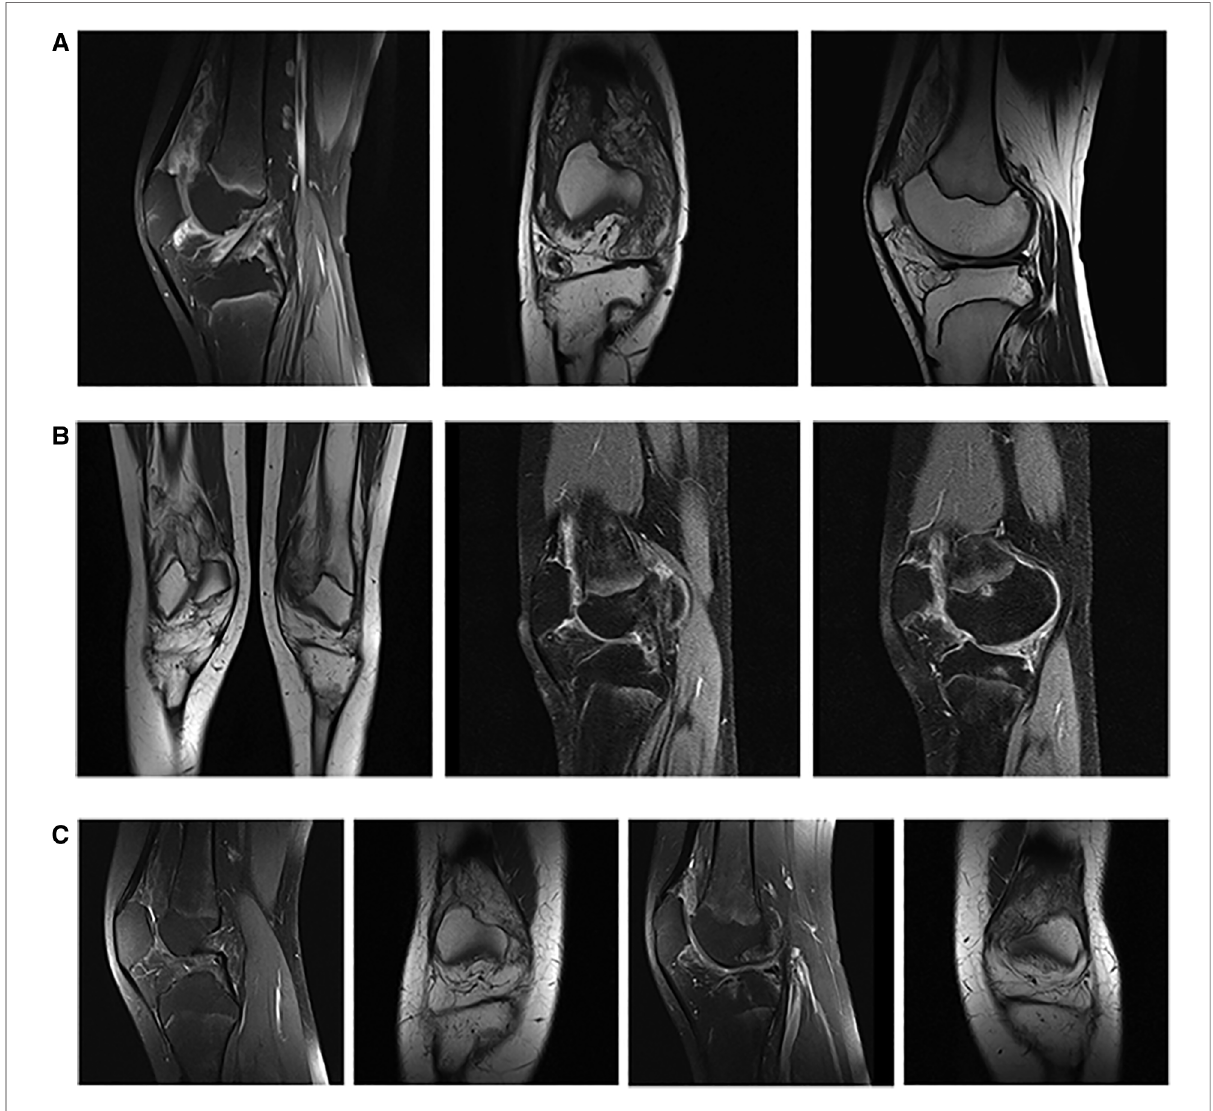
FIGURE 2 Imaging examinations. ( A ) Initial MRI scanning of the right knee [MRI Proton Density with Fat Saturation (PDFS), sagittal plane; MRI T1 weighted image, coronal plane; MRI T1 weighted image, sagittal plane] showed the extended intra-articular synovial proliferation with fat inclusions combined with multiple marginal bony erosion of the proximal tibia, both femoral condyles and patella along with altered morphology of both menisci. ( B ) Control MRI of both knees (MRI T1 weighted image, coronal plane; MRI Proton Density with Fat Saturation (PDFS), sagittal plane, right; MRI Proton Density with Fat Saturation (PDFS), sagittal plane, left) performed after 2 years of MTX therapy with almost the same, bilateral lesions as one on the initial MRI of the right knee. ( C ) Second MRI control of both knees [MRI Proton Density with Fat Saturation (PDFS), sagittal/coronal plane, right/left] with almost complete regression of the synovial proliferation in the right, and partial regression in the left knee after 6 months of TNF inhibitor